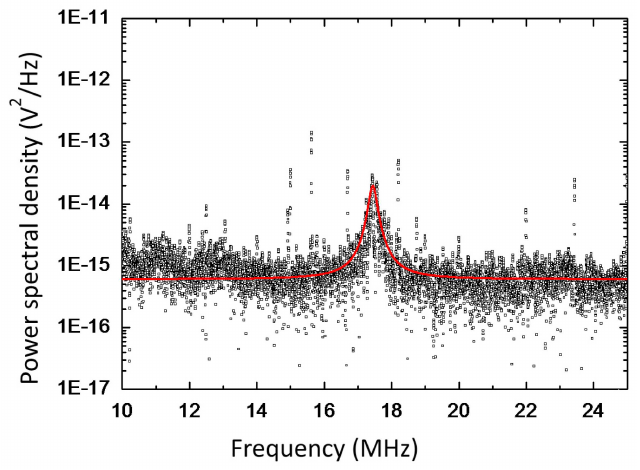
Figure 3. Power spectral density of the mass spectrum and its Lorenztian fit (red line), it clearly shows the resonance at 17.5 MHz. This resonance peak appeals only when the ions bombard the